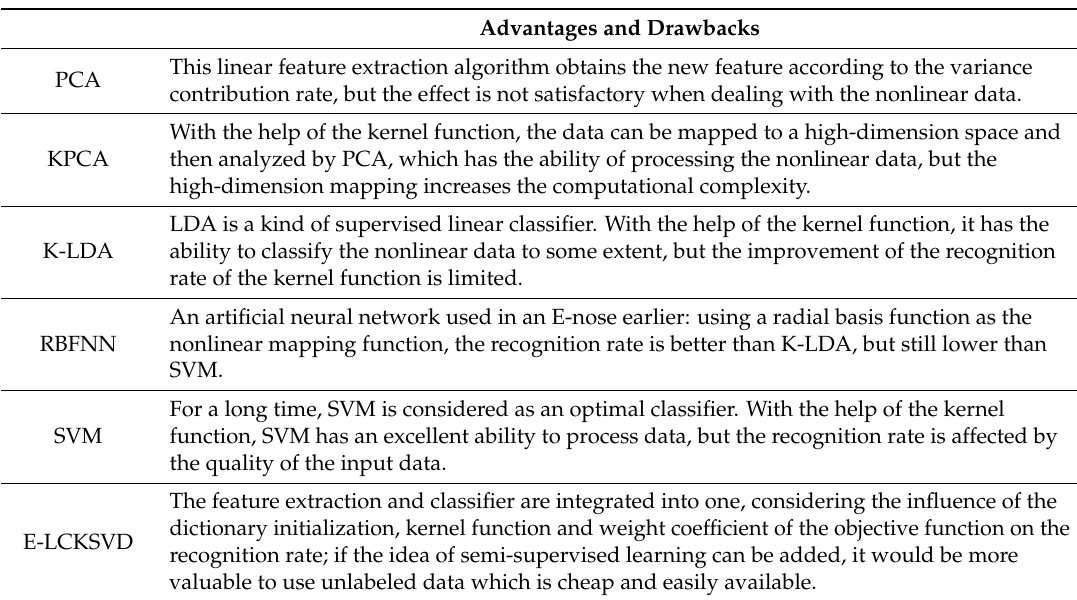
Table 9. The advantages and drawbacks of all the techniques used in this paper. Advantages and